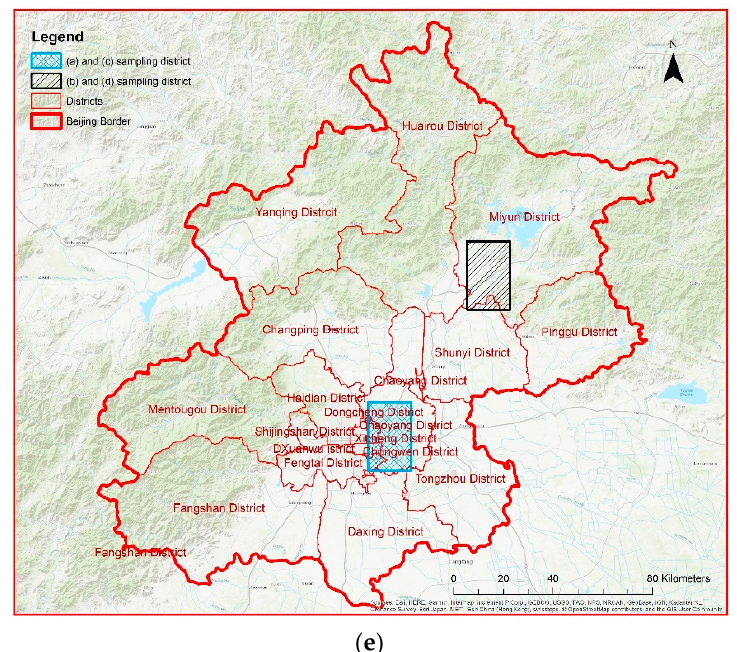
Figure 8. The spatial distribution of a random selection of users within each Voronoi polygon for different areas and times: ( a ) random users within a high-density area at 2:00 a.m.; ( b ) random users within a low-density area at 2:00 a.m.; ( c ) random users within a high-density area at 10:00 a.m.; ( d ) random users within a low-density area at 10:00 a.m.; ( e ) Illustration showing the location of the areas with high and low population density used for the analysis of the time prediction.